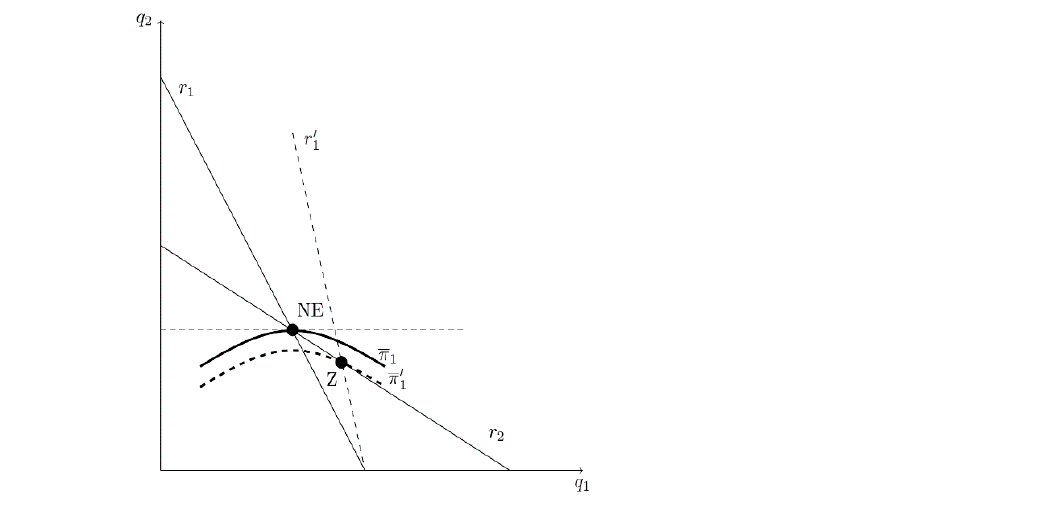
Figure 3. Owner 1’s Incentive to Hire a CEO Who Underestimates Product Substitutability in the Cournot Model. Table 1. Equilibrium values when firms compete in